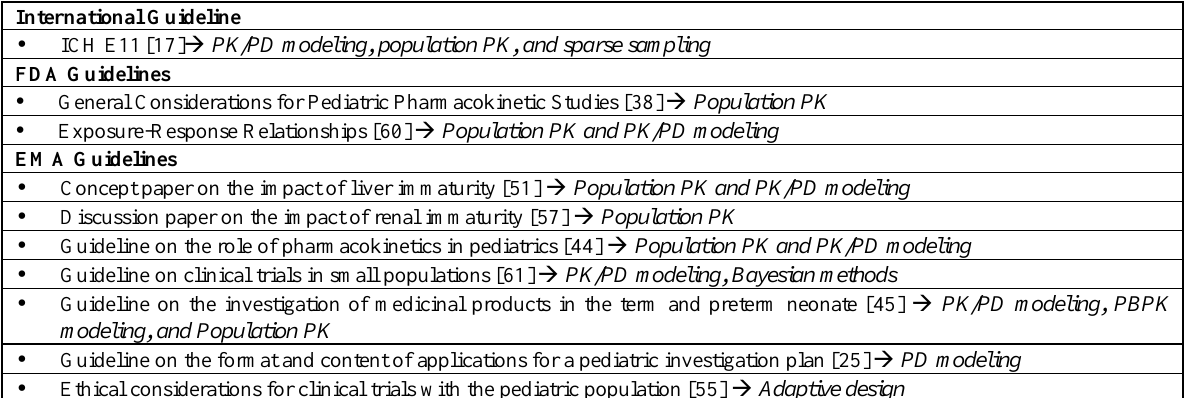
Table 8. Regulatory basis for Modeling and Simulation in